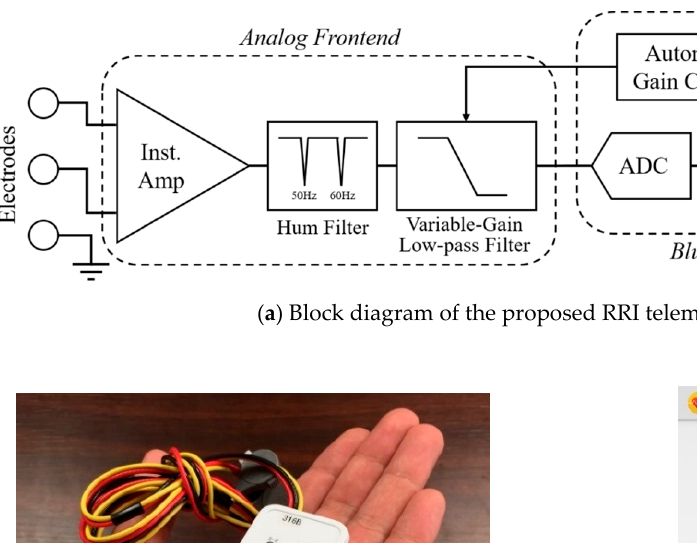
Figure 1. System overview and signal processing workflow of the proposed epileptic seizure prediction system.